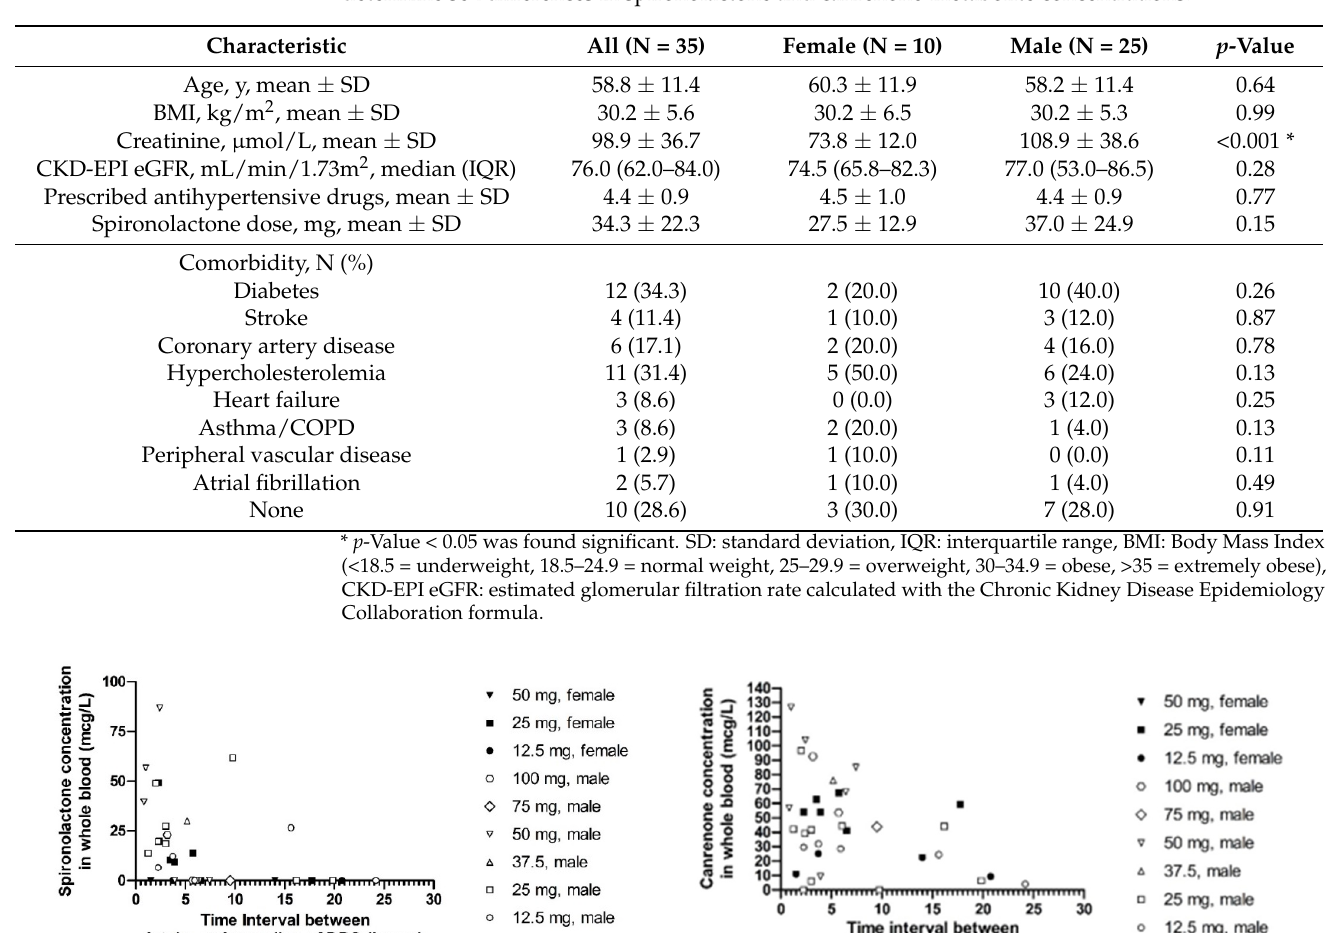
Table 2. Baseline characteristics patients from RHYME-RCT trial used in linear regression analysis to determine sex differences in spironolactone and canrenone-metabolite concentrations.